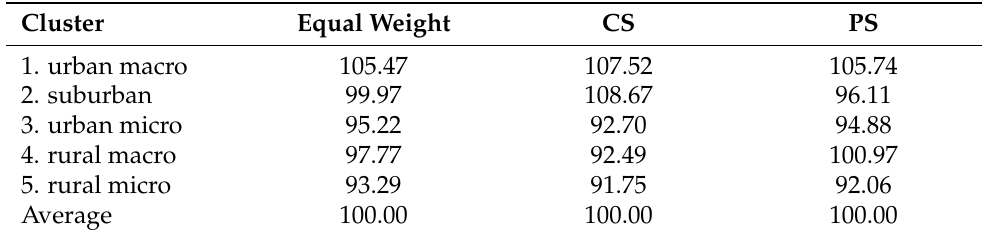
Table 7. Composite indicator using reference to average indicator per cluster. Average indica- tor = 100.00.